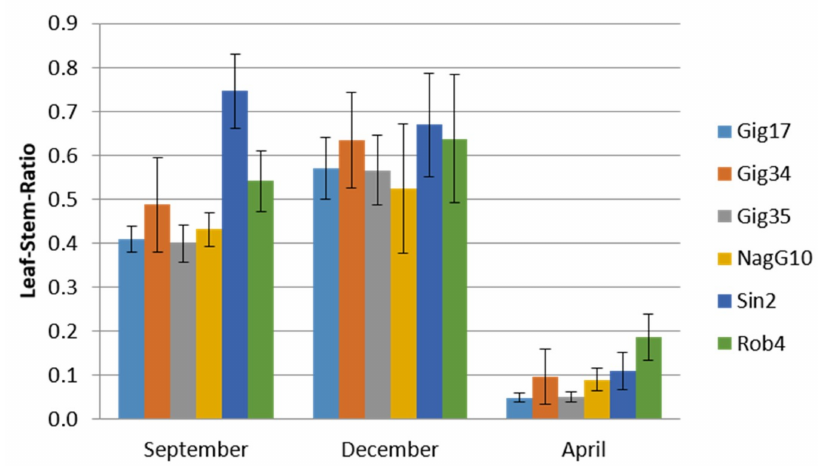
Figure 2. Miscanthus crop analysis via NREL measurements. Leaf versus stem content of Miscanthus genotypes: M . x giganteus (Gig17, Gig34, Gig35), M . nagara (NagG10), M . sinensis (Sin2), and M . robustus (Rob4) harvested in September (09/15), December (12/14), and April (04/15), respectively (arranged to follow the seasonal order from autumn to spring).